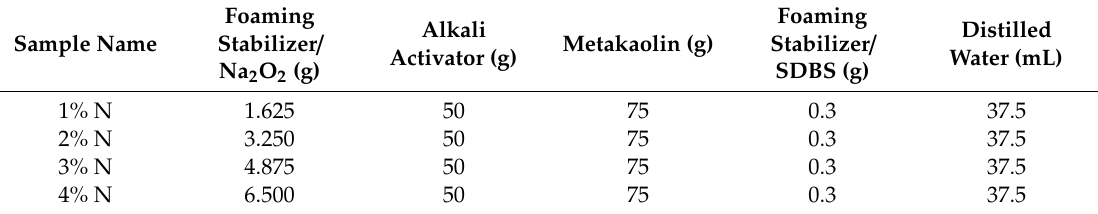
Table 2. Compositions of the mixtures to prepare geopolymer foams.